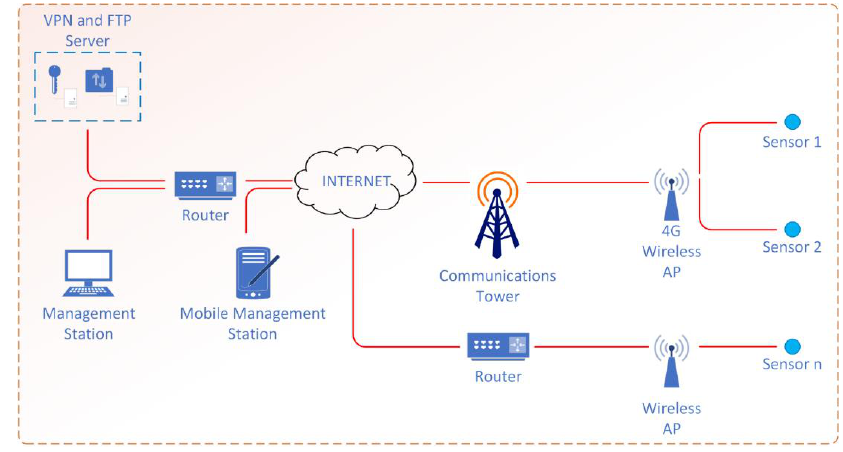
Figure 10. Network architecture for the remote management of the sensors.